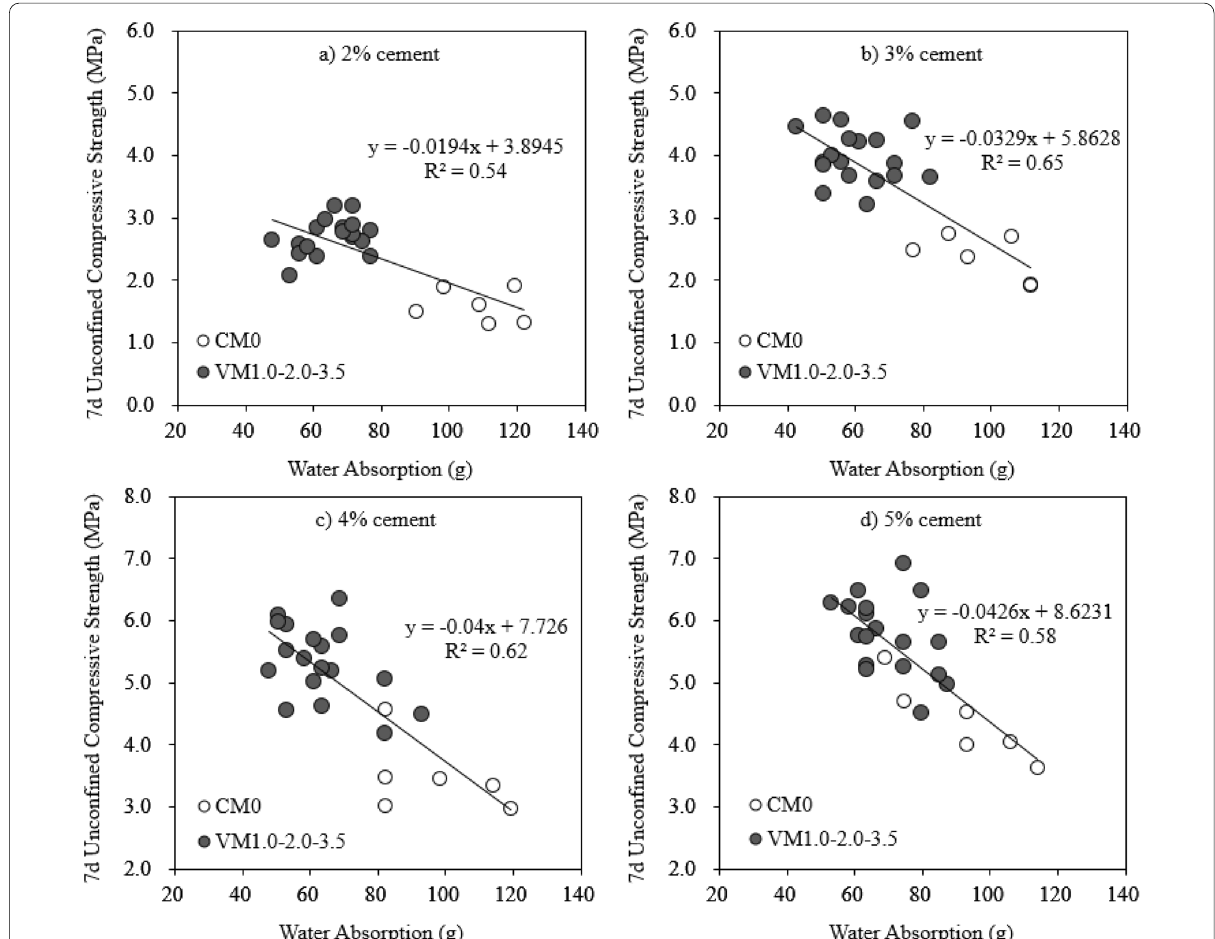
Fig. 10 The relationship between water absorption and 7-day UCS of the CSM with different cement dosage: a 2% cement dosage; b 3% cement dosage; c 4% cement dosage; (5) 5% cement